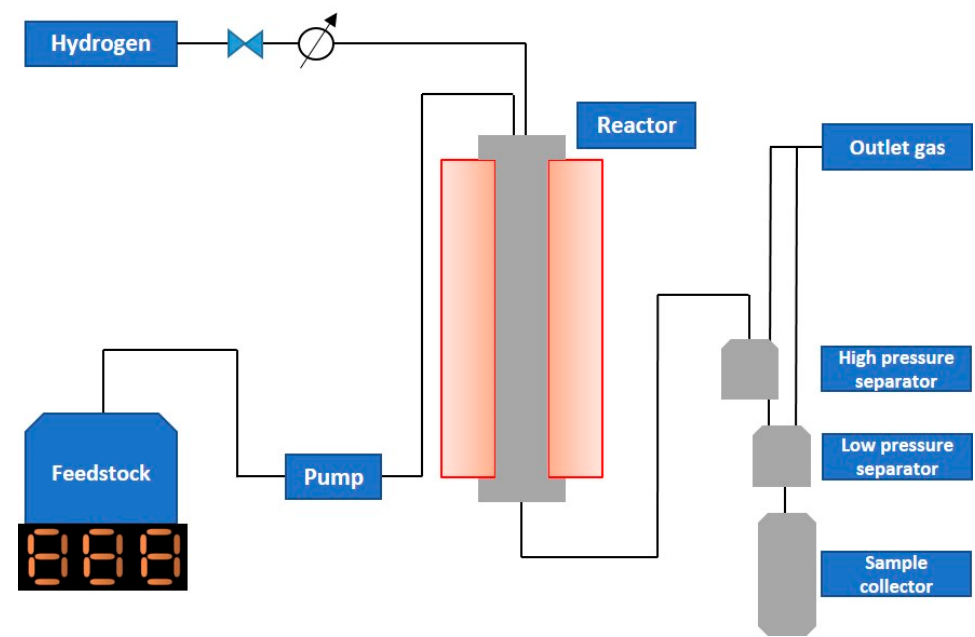
Figure 2. Flow Unit 909-203.